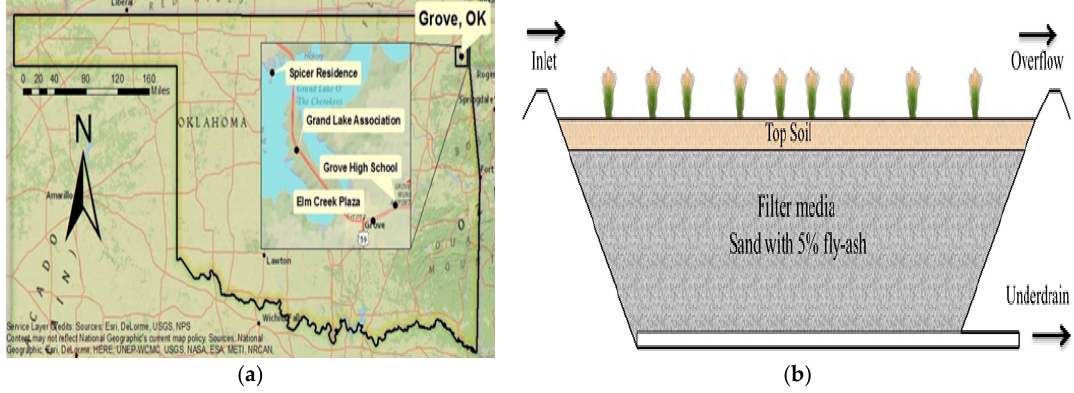
Figure 1. ( a ) Bioretention cell locations at Grove, Oklahoma; ( b ) Typical section of bioretention cell at Grove, Oklahoma. Table 1. Design summary for four bioretention cells [Grand Lake Association (GLA), Grove High School (GHS), Elm Creek Plaza (ECP), Spicer Residence (SR)] used in the field study at Grove, Oklahoma, USA [38].